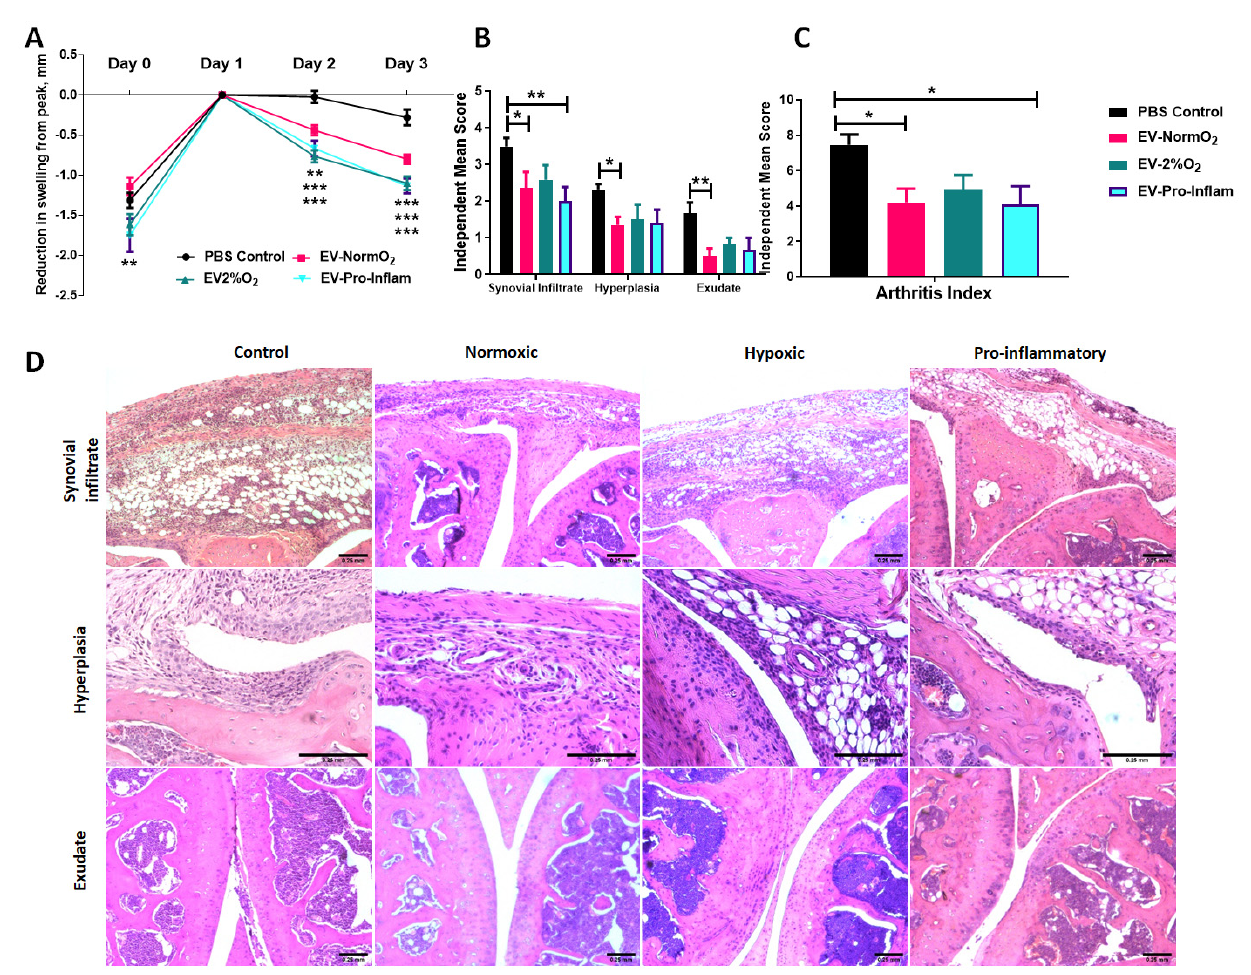
Figure 2. MSC-derived EVs treatment of mice with AIA. ( A ) Alleviation of joint swelling as a meas- ure of therapeutic efficacy following EV treatments shows a significant effect of EVs compared to vehicle controls at day 2 and day 3 after arthritis induction; normalised to 0 at peak swelling (day 1) (2 Way ANOVA with Repeated Measures and Bonferroni multiple comparisons test post hoc) ( B